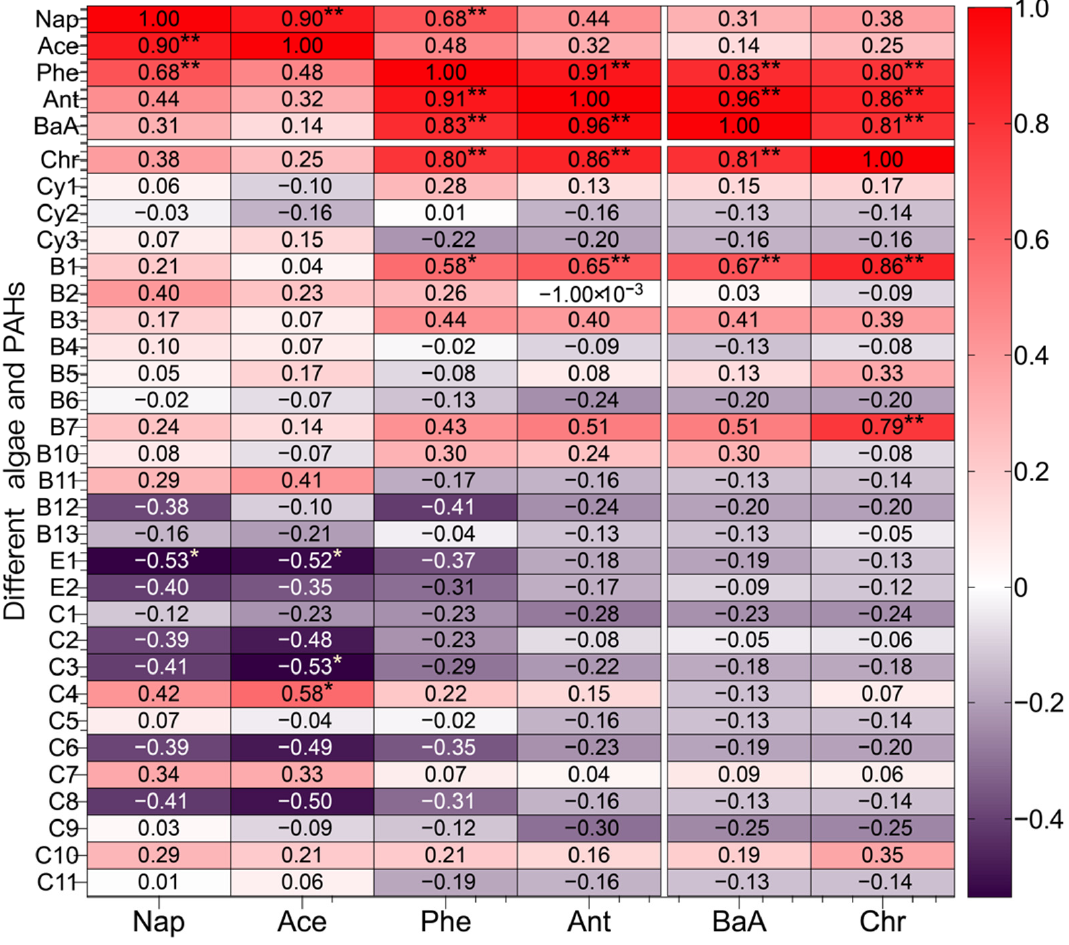
Figure 4. The Pearson correlation analysis between PAHs concentration and algae biomass. Note: (1) **: Correlation is significant at the 0.01 level (2-tailed); *: correlation is significant at the 0.05 level (2-tailed). (2) Naphthalene (Nap), acenaphthylene (Ace), phenanthrene (Phe), anthracene (Ant), benzo[a]anthracene (BaA), chrysene (Chr). (3) The codes of phytoplankton are listed in Table 1. When phytoplankton abundance data acted as the species matrix and the residues of PAHs as the environmental matrix, the eigenvalues of the first two species axes were 0.210 and 0.118, and the total eigenvalue was 1.000 (Table 2). The first two species axes explained 71.30% of the total information amount. The correlation coefficients between the first two species axes (phytoplankton abundance) and the first two environmental axes (PAHs) were 0.8212 and 0.8858, respectively. The correlation coefficient of the first two species ordination axes and of the first two environmental axes (PAHs) were 0.1298 and 0.000 (indicating little correlation), respectively. When we reversed these data matrices (Figure 5B), the residues of PAHs acted as the species matrix and the phytoplankton abundance data as the environmental matrix. The eigenvalues of the first two species axes were 0.6080 and 0.3259 (Table 2), respectively, explained 93.39% of the total information amount. The correlation coefficients between the first two species axes (PAHs) and the first two environmental axes (phytoplankton abundance) were all 1.000, respectively. The correlation coefficients of the first two species ordination axes and of the first two environmental axes (PAHs) were all 0.000. These RDA results suggested that the ordination could reflect the exact relationship between phytoplankton species and the residues of